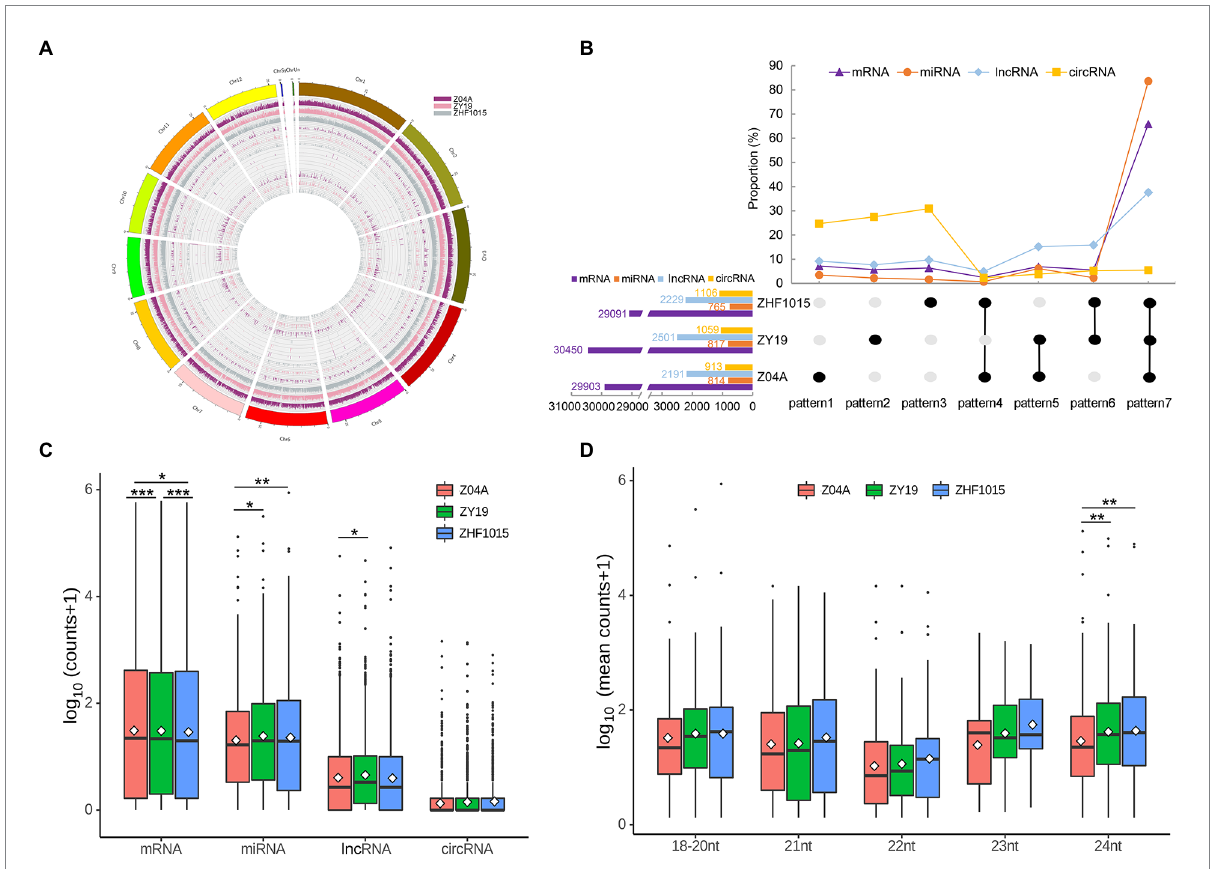
FIGURE 2 ncRNA profiles of the hybrid and its parents. (A) Location information and expression levels of four types of RNAs in the three varieties. mRNA, lncRNA, circRNA and miRNA from outside to inside. Different colors indicate different varieties. (B) The number of RNA expressed by different varieties. (C) Expression levels of four RNAs in the three varieties. (D) Expression levels of miRNA of different length in three varieties. *** means significant difference with p < 0.001, ** means significant difference with p < 0.01, and * means significant difference with p <